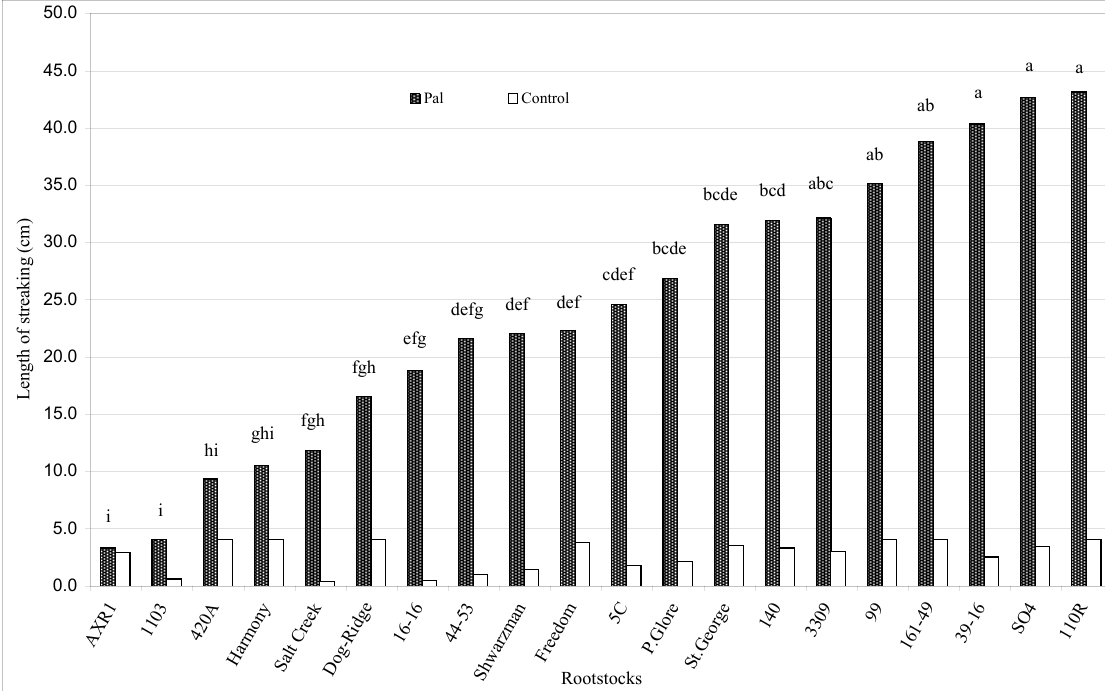
Fig. 4. Length of vascular streaking (cm) in Phaeoacremonium aleophilum (Pal) inoculated